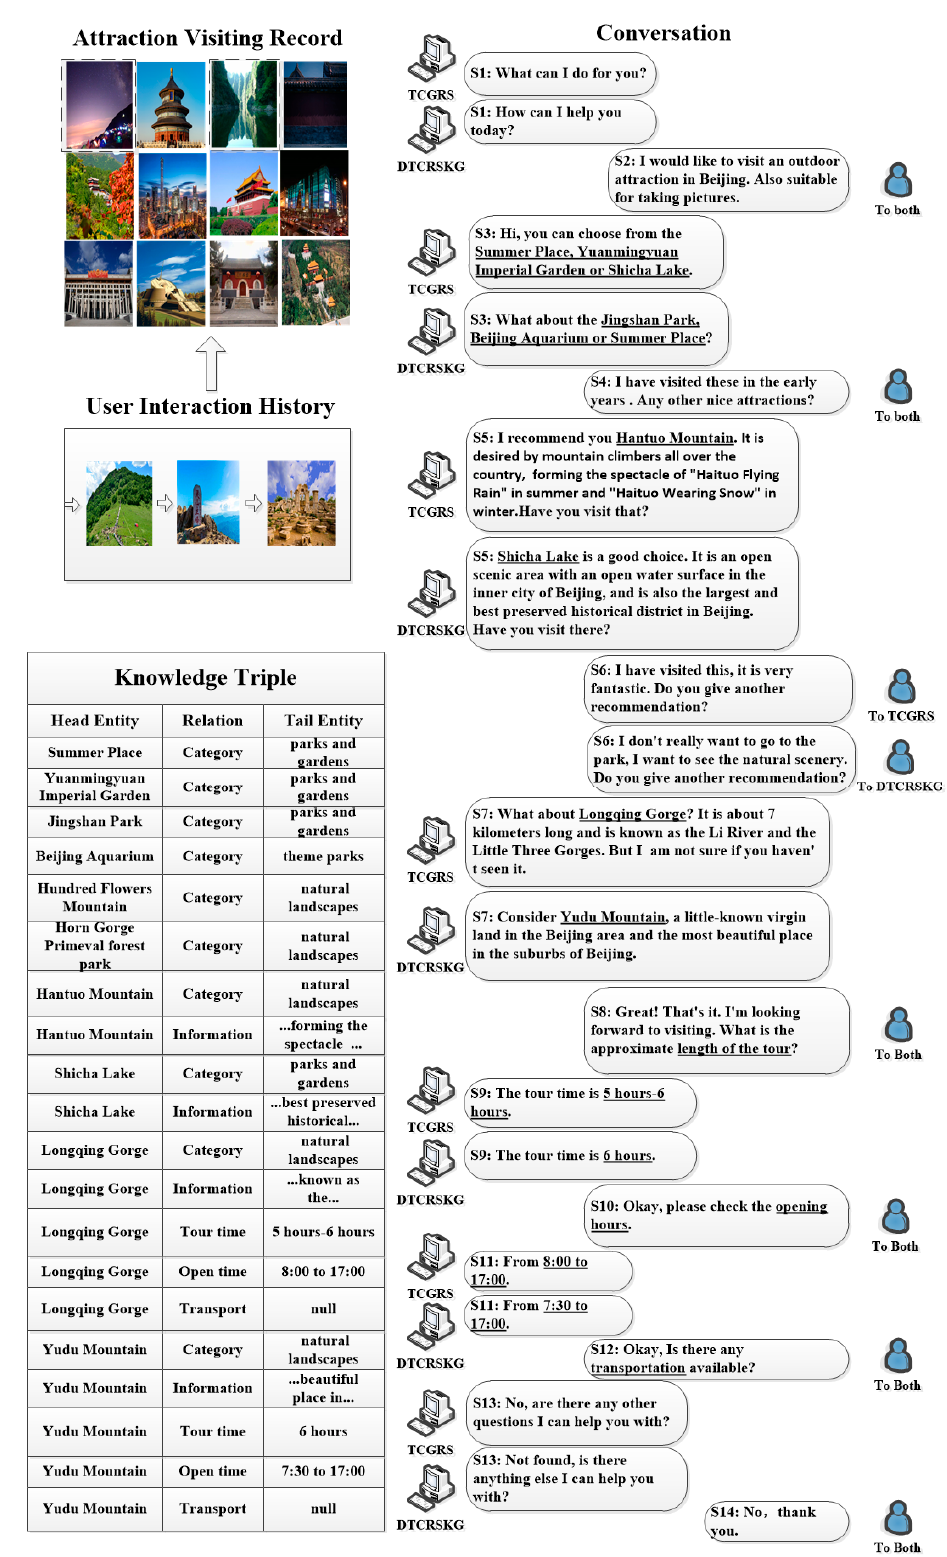
Figure 8. Sample travel conversational recommendation. We underlined the entities and relations in the knowledge triple mentioned therein. We selected two attractions, which is boxed by the dashed line, sharing the same category in the user interaction history from the visiting record that corresponded to the attractions recommended successfully by the conversation. The rightmost section shows the corresponding knowledge triplets.